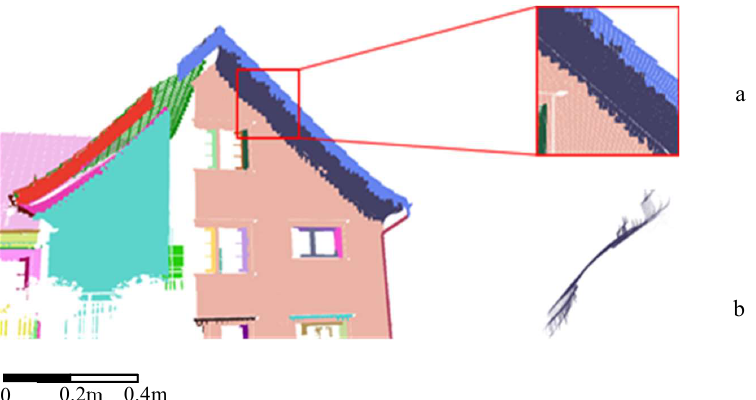
Figure 16. Sawtooth boundary in curved surface point cloud. ( a ) Details of sawtooth point cloud, and ( b ) bending section of sawtooth point cloud.